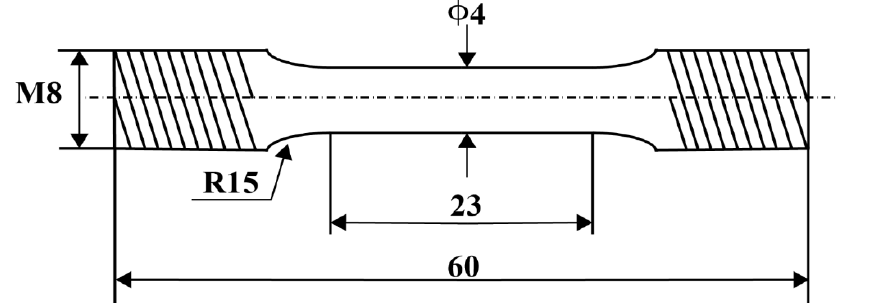
Figure 3. Schematic diagram and dimensions of the tensile samples (dimensions are in millimetres).